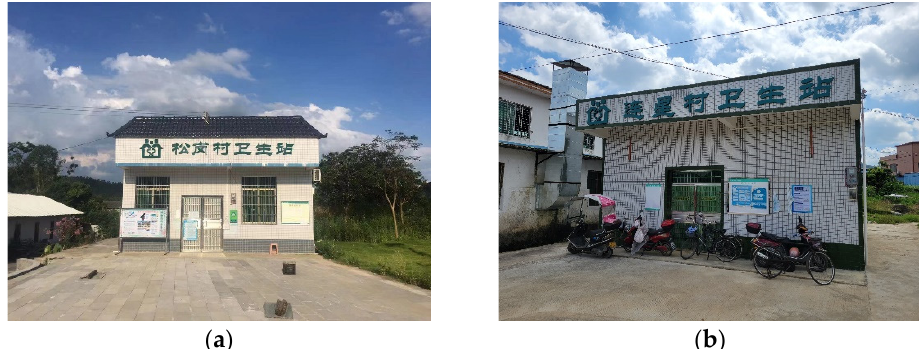
Figure 11. Village health office without village doctors on duty. ( a ) Scene of a village in Wengyuan County, Guangdong Province; ( b ) scene of a village in Lianping County, Guangdong Province (Source: by the authors).